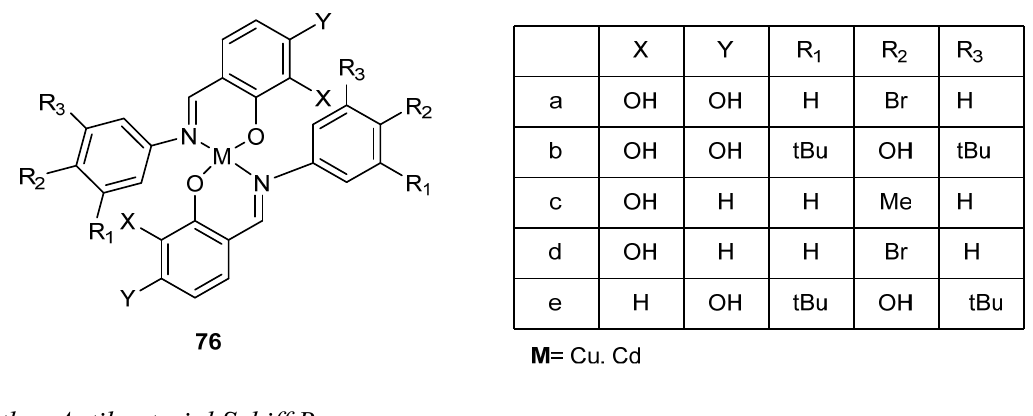
Figure 6. Cu(II) and Cd(II) complexes of salicylidenebenzylamines.